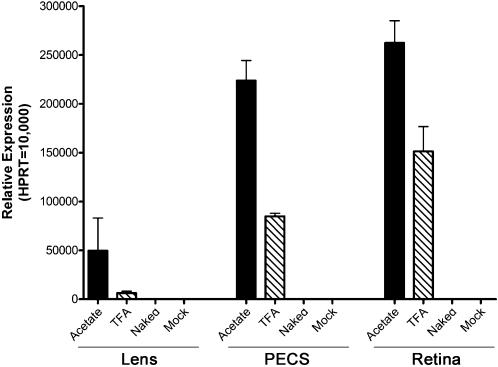
Ocular expression levels of EGFP mRNA after subretinal injection.At 2-days post-subretinal injection of 0.6 µg of compacted DNA, the lens, PECS, and retina were isolated, and qRT-PCR was used to assess EGFP mRNA levels.Both the AC-GFP and TFA-GFP nanoparticles produced substantial expression in the PECS and retina.In both tissues, the AC-GFP nanoparticle generated EGFP mRNA levels nearly 2-fold higher than the TFA-GFP nanoparticle.EGFP expression was also observed in the lens; however there was significant deviation between samples, possibly reflecting the amount of nanoparticle reflux into the vitreous because of back-pressure during syringe withdrawal following some of the subretinal injection procedures.